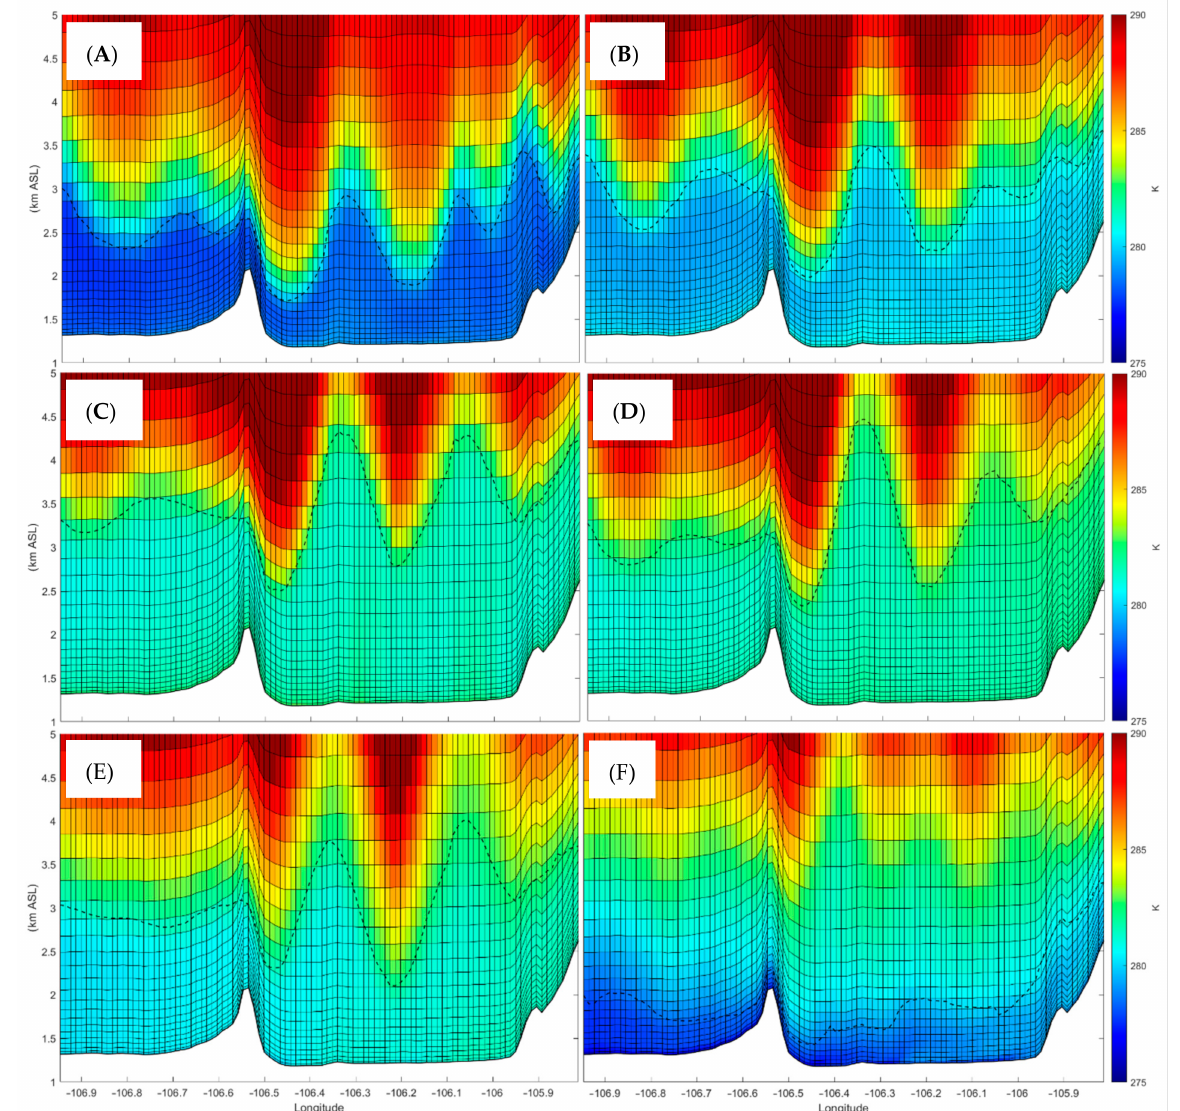
Figure 12. WRF potential temperature, θ and boundary layer depth (dashed line) vertical cross-sections, 17 April 2018. ( A ) 1700 UTC, stable stratification during lee wave regime. ( B ) 1900 UTC, unstable stratification at surface during LRS transition. ( C ) 2100 UTC, unstable stratification at surface, near neutral conditions throughout remaining BL depth during fully developed LRS. ( D ) 2300 UTC, essentially unchanged since 2100 UTC. ( E ) 0100 UTC, BL height decreasing due to surface cooling while transition from LRS to lee waves occurs. ( F ) 0300 UTC, stable stratification remerges throughout the BL post